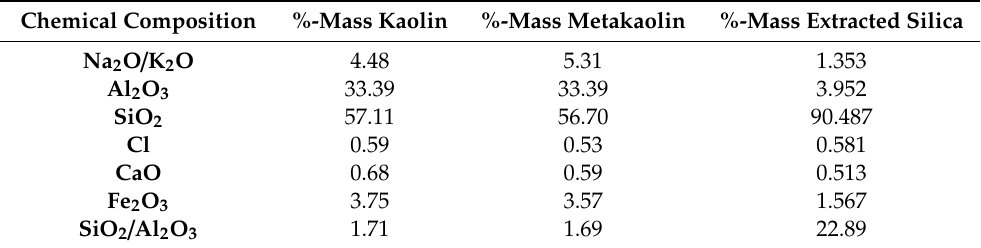
Table 1. Composition of the raw kaolin, metakaolin and extracted silica precursors.